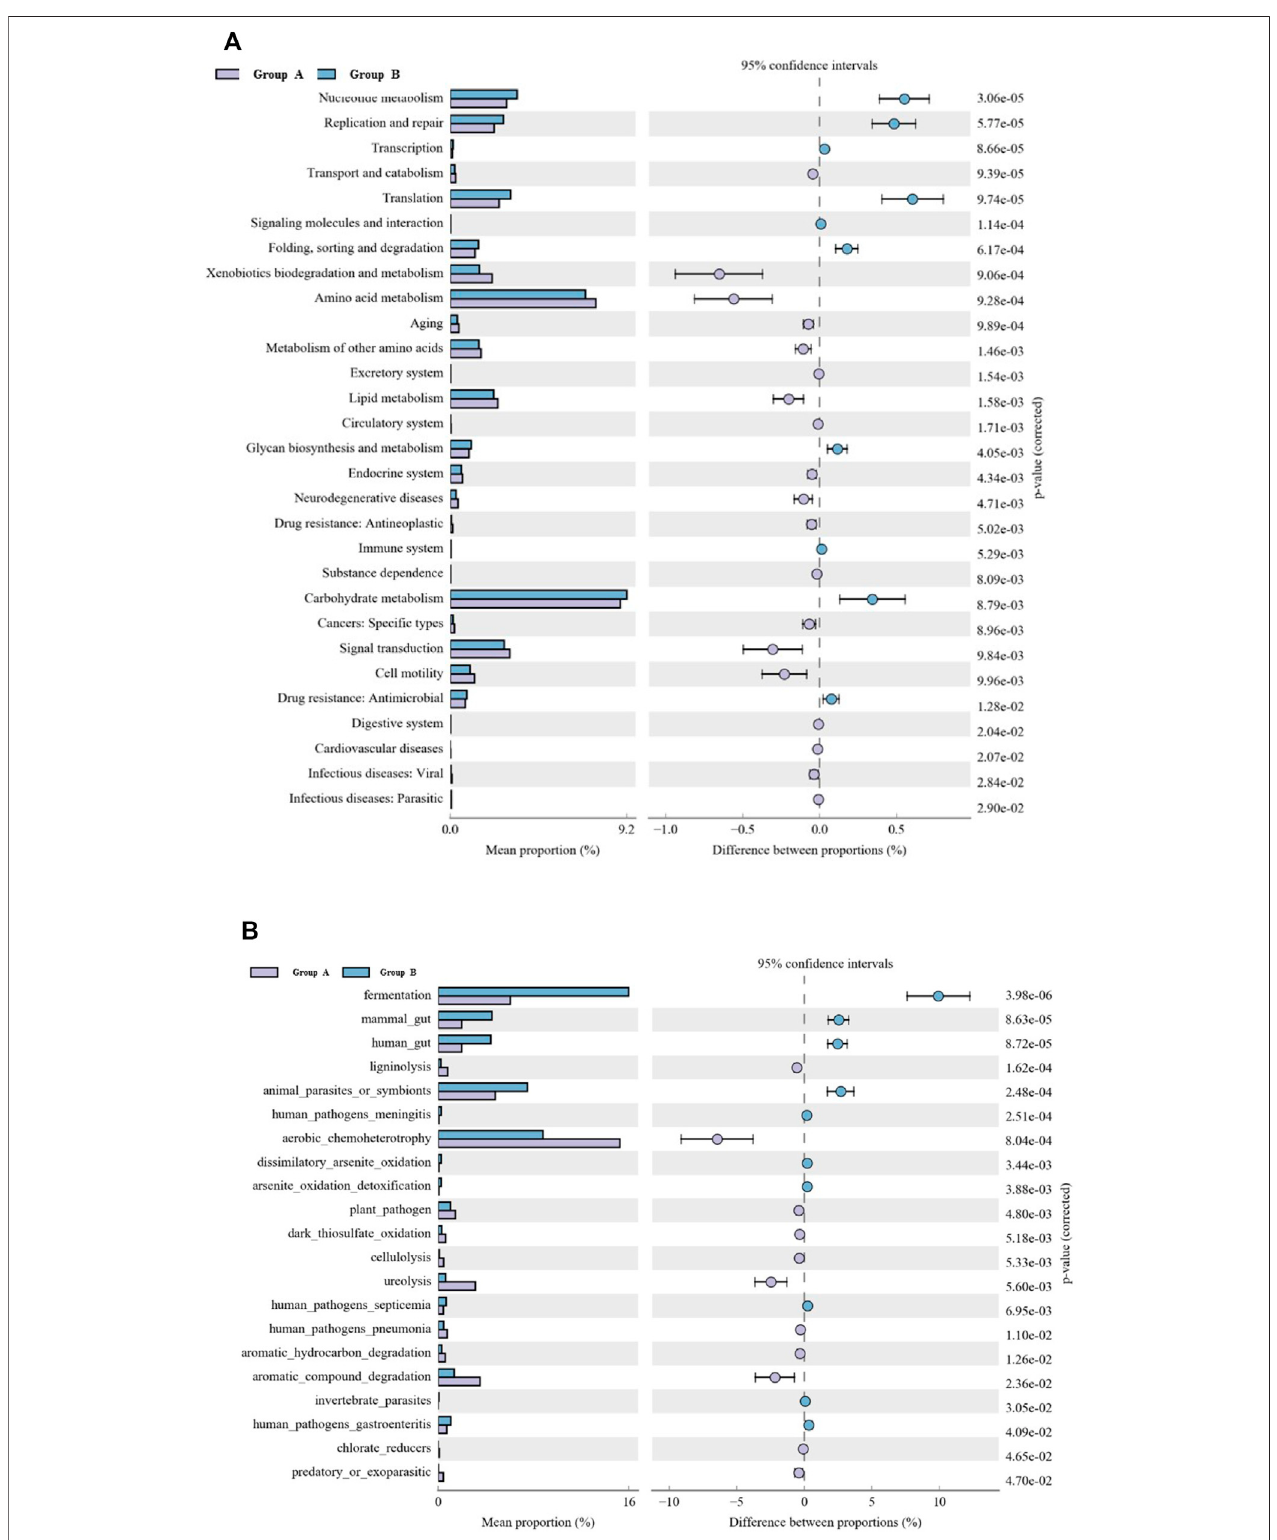
FIGURE 8 | Variation in bacterial function pro fi les between group A and group B analyzed by PICRUSt (A) and FAPROTAX (B) . Note: The level 2 KEGG ortholog function predictions about the abundance of the main metabolic functions. The different colors in the picture represent different groups. The left fi gure in the picture shows the abundance ratio of different functions in two samples or two groups of samples, the middle shows the difference ratio of the function abundance within the 95% con fi dence interval, and the rightmost value is the p value.